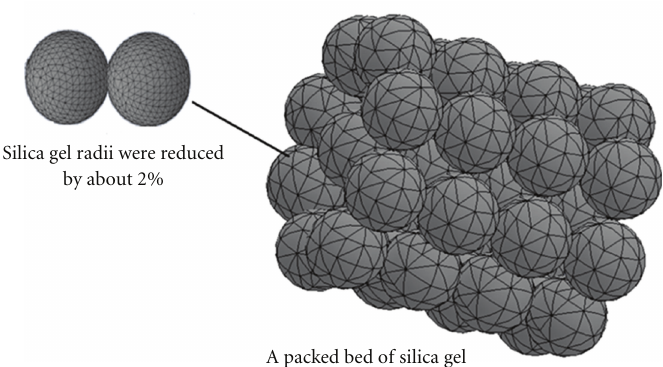
Figure 7: 3D dimensional display and detail of the control volumes in the fluid region near particle-to particle contact points.